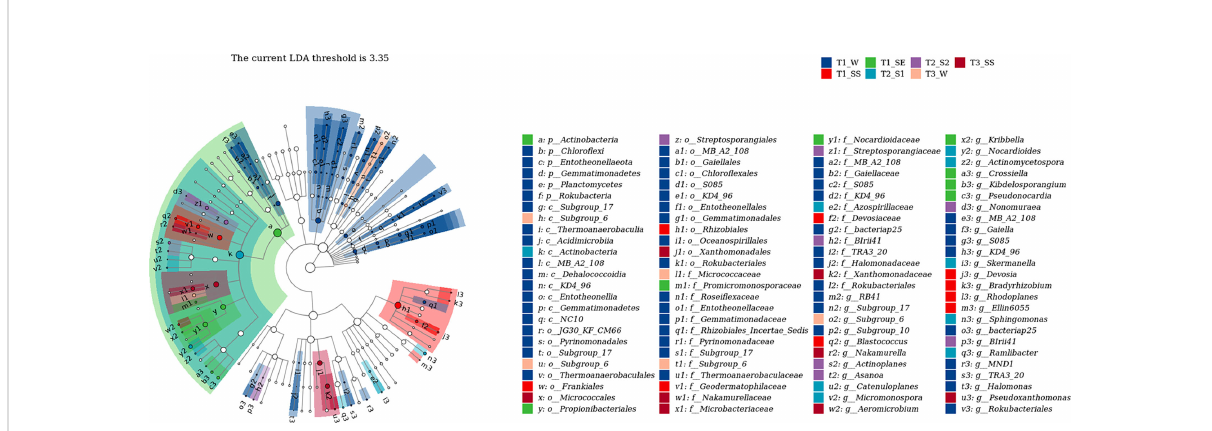
FIGURE 10 Linear discriminant analysis (LDA) effect size (LefSe) for bacteria in soils belonging to different water-repellency classes beneath Pinus (T 1 ), Hippophae (T Robinia (T 2 ), and 3 ).